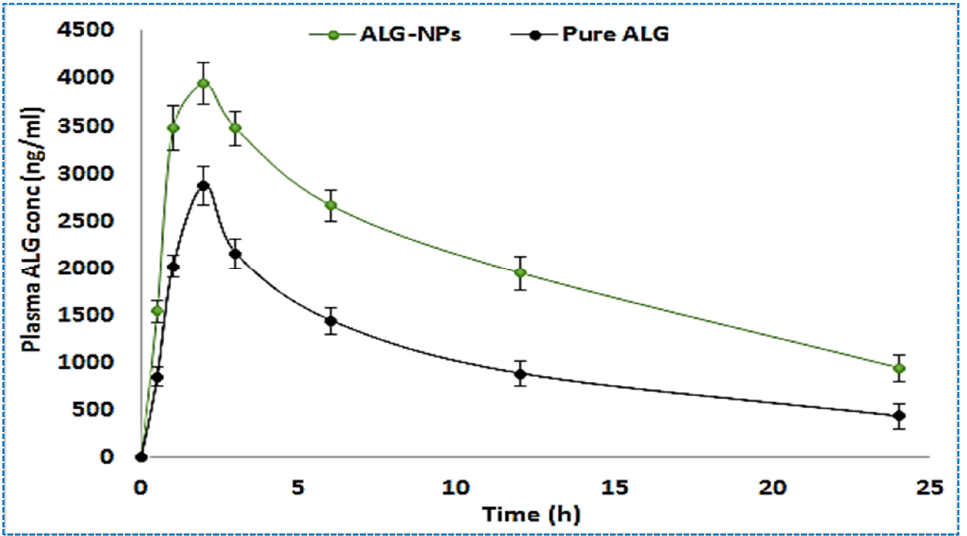
Figure 9. Comparative pharmacokinetic study profile of pure ALG and optimized ALG-NPs. Each study performed using six samples and data presented as mean ± SD.